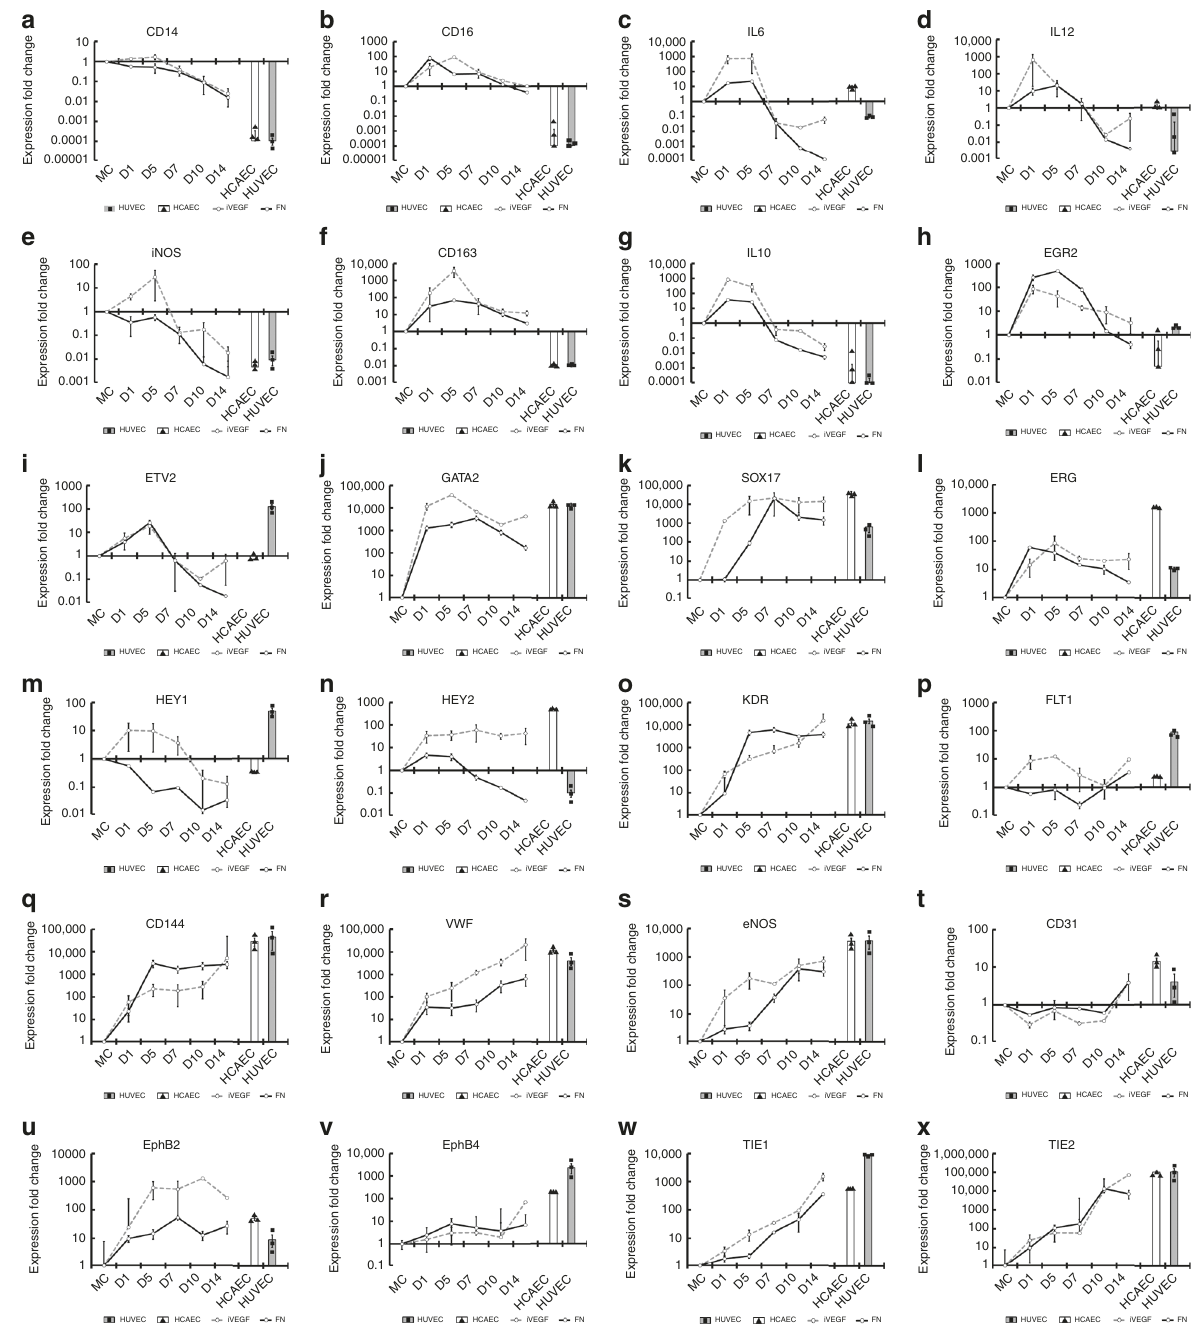
Fig. 5 Gene expression pro fi le as MC differentiate towards EC. Quanti fi cation of gene expression via quantitative PCR over MC at day 0. All genes were internally normalized to RPL32 cycle number. HUVEC (gray bars) and HCAEC (white bars) gene expression served as a comparison references ( a – x ). Monocyte markers ( a , b ); M1 macrophage markers ( c – e ); M2 macrophage markers ( f – h ); Endothelial transcription factors ( i – n ); Endothelial functional markers ( o – x ). Error bars indicate ±SD of the mean over n = 3 independent biological replicates. Each PCR reaction was conducted with triplicate for each